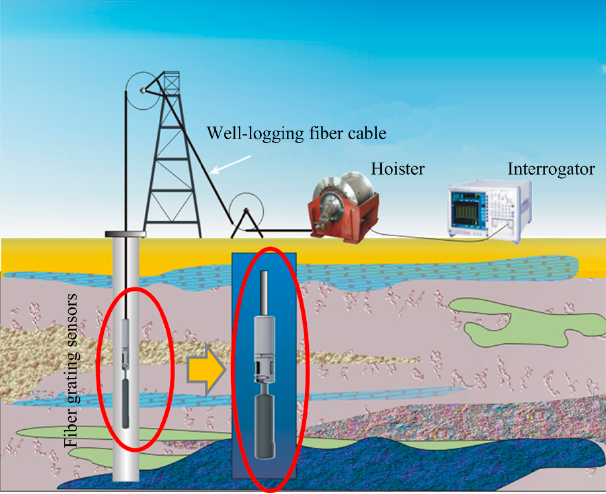
Figure 21. Schematic diagram of the downhole testing.